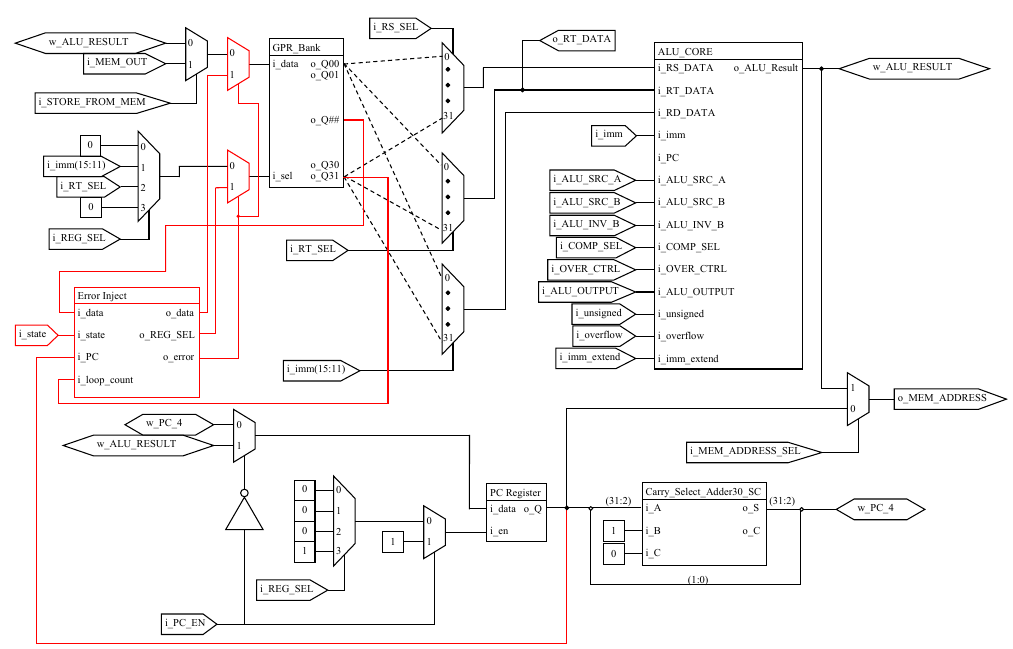
Figure A2. Basic MIPS Datapath With Error Injection